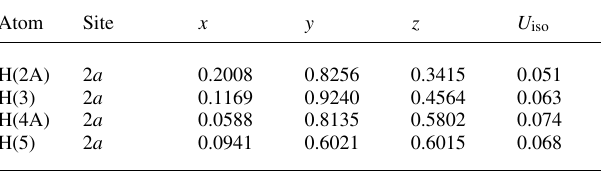
Table 2. Atomic coordinates and displacement parameters (in Å 2 )